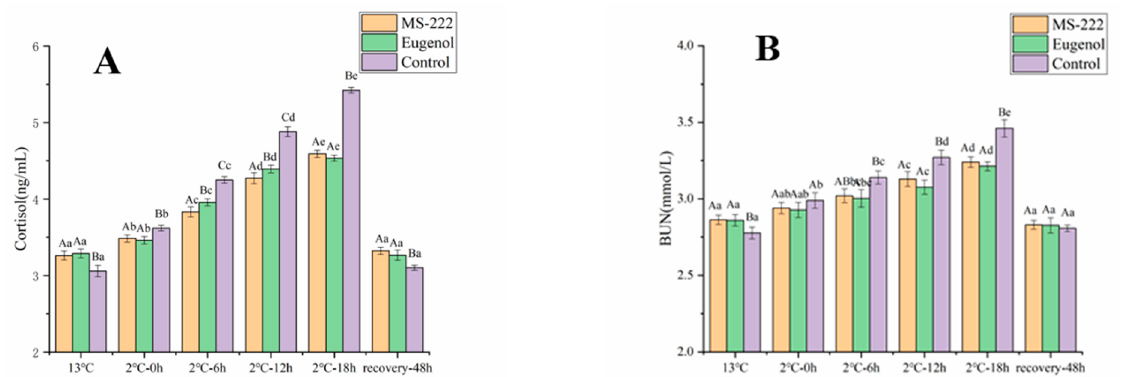
Figure 3. Cortisol ( A ) and BUN ( B ) changes in turbot affected by low-temperature transport stress. Different capital letters indicate significant differences in means between different treatment groups. Different lowercase letters indicate significant differences in means between the same treatment groups ( p < 0.05).